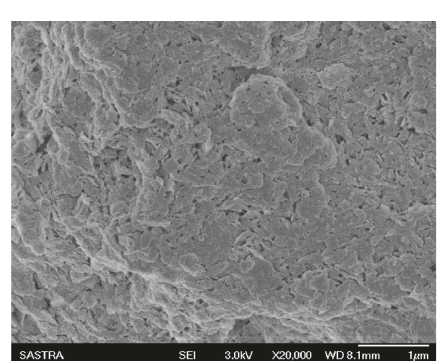
Figure 2: Microstructure of